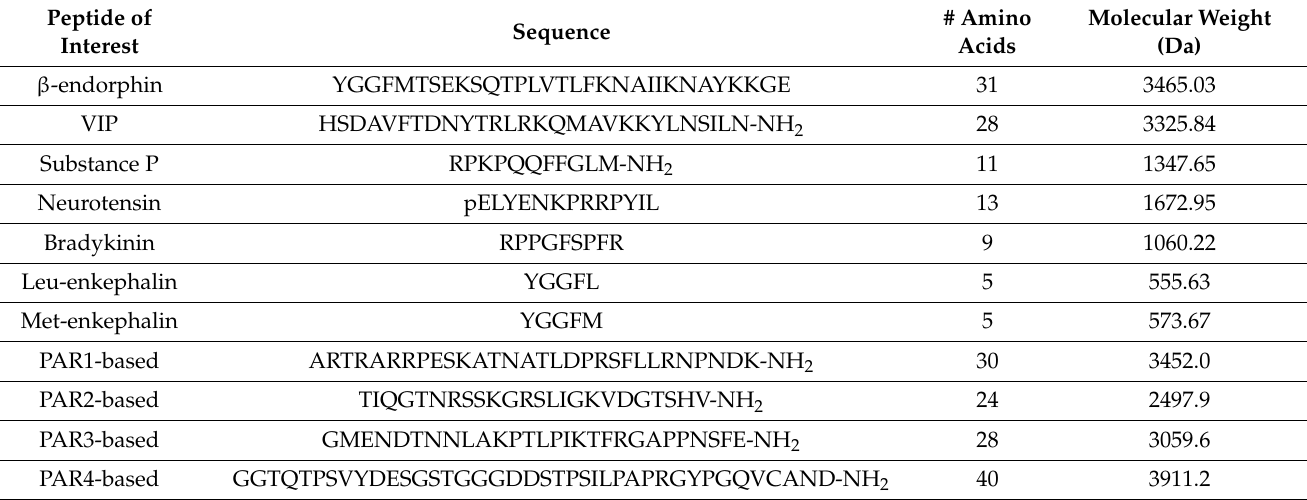
Table 2. Sequences of the synthetic peptides used in the reaction mixtures for MALDI-TOF/TOF experiments. The number (#) of amino acids and the molecular weight are shown for each peptide. Peptide